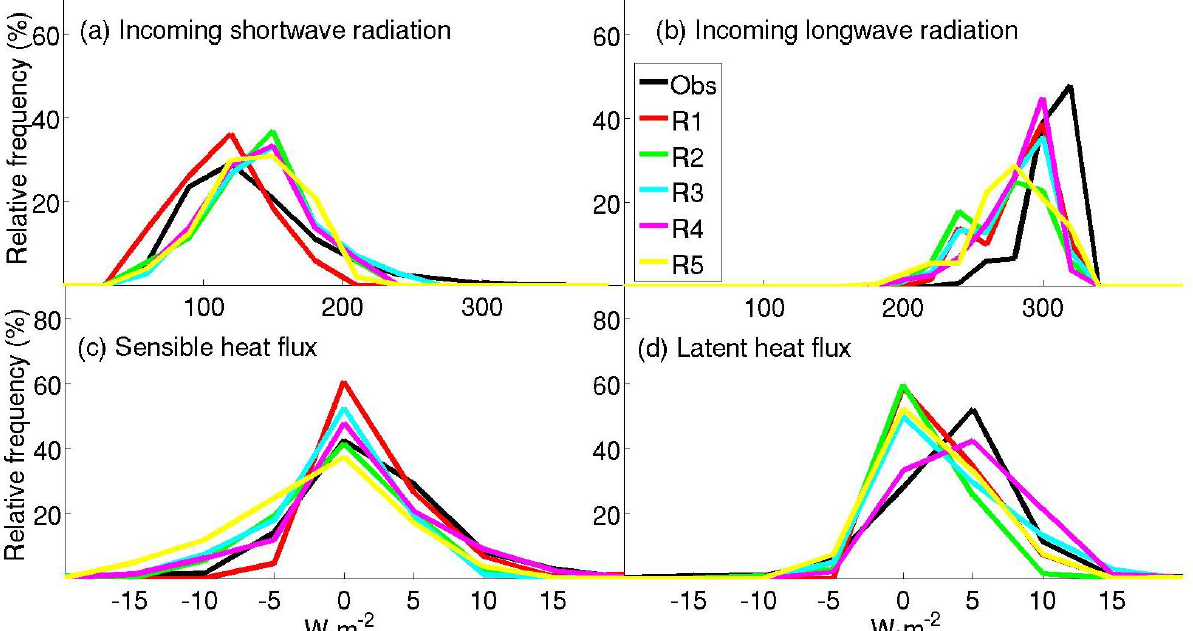
Figure 12. PDF of ( a ) incoming shortwave, ( b ) incoming longwave, ( c ) sensible heat and ( d ) latent heat fluxes, all in Wm −2